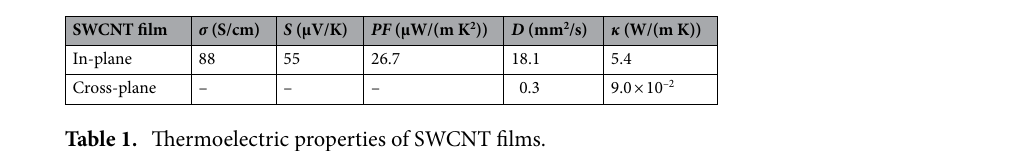
Table 1. Thermoelectric properties of SWCNT